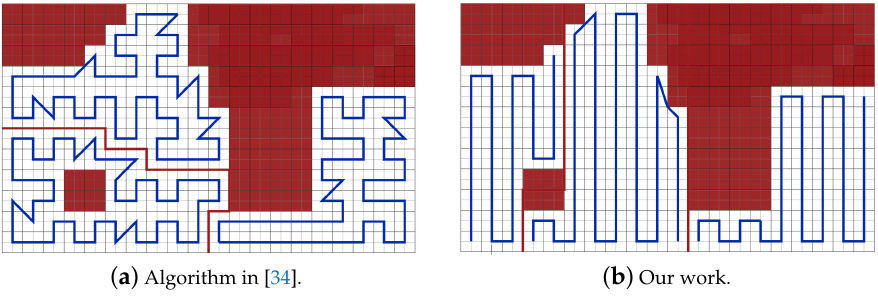
Figure 34. Paths generated by the algorithms in [34] and by our